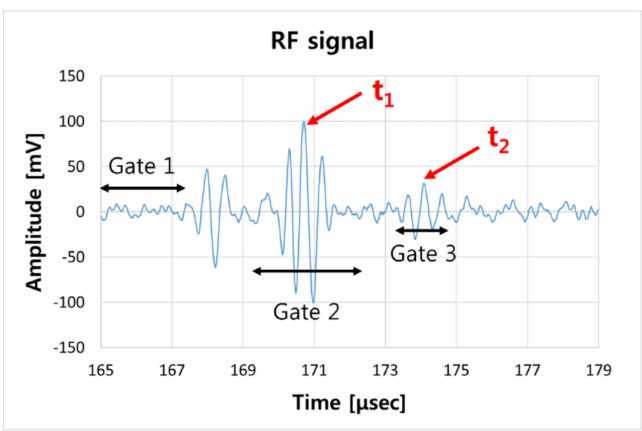
Figure 3. Typical ultrasonic rf signals by a developed waveguide with the pitch / catch method at 150 ◦ C.